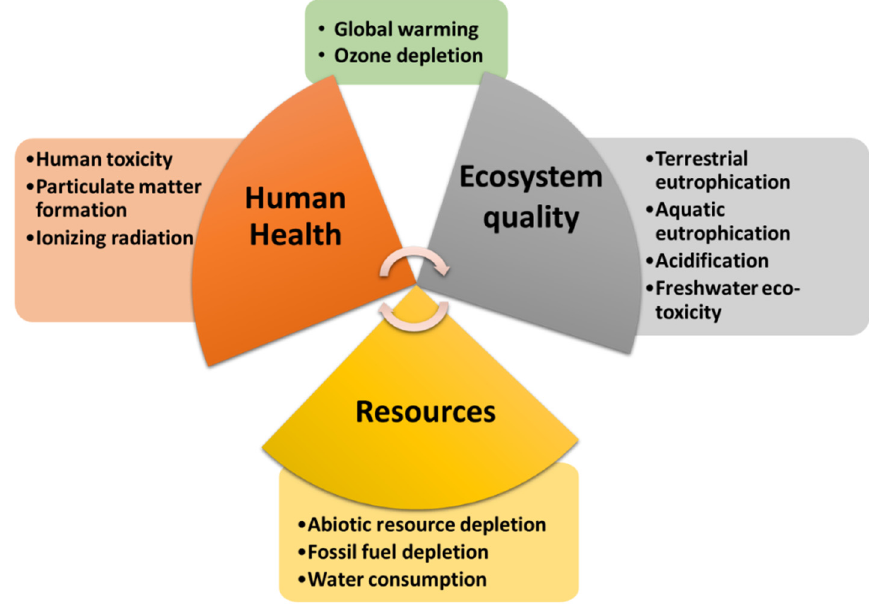
Figure 2. Ecosystem, human health, and resource impacts in the LCIA.